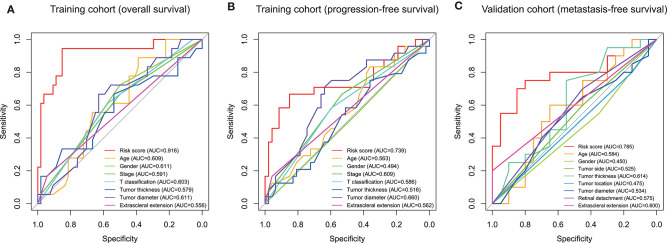
Receiver operating characteristic (ROC) analysis of the ten-gene signature risk score. ROC analysis of the sensitivity and specificity of the prognosis prediction by the ten-gene risk score, age, gender, T classification, tumor stage, tumor thickness, tumor diameter, tumor side, tumor location, extrascleral extension, or retinal detachment in training cohort based on overall survival (A), training cohort based on progression-free survival (B), and validation cohort based on metastasis-free survival (C). AUC, area under the ROC curve.